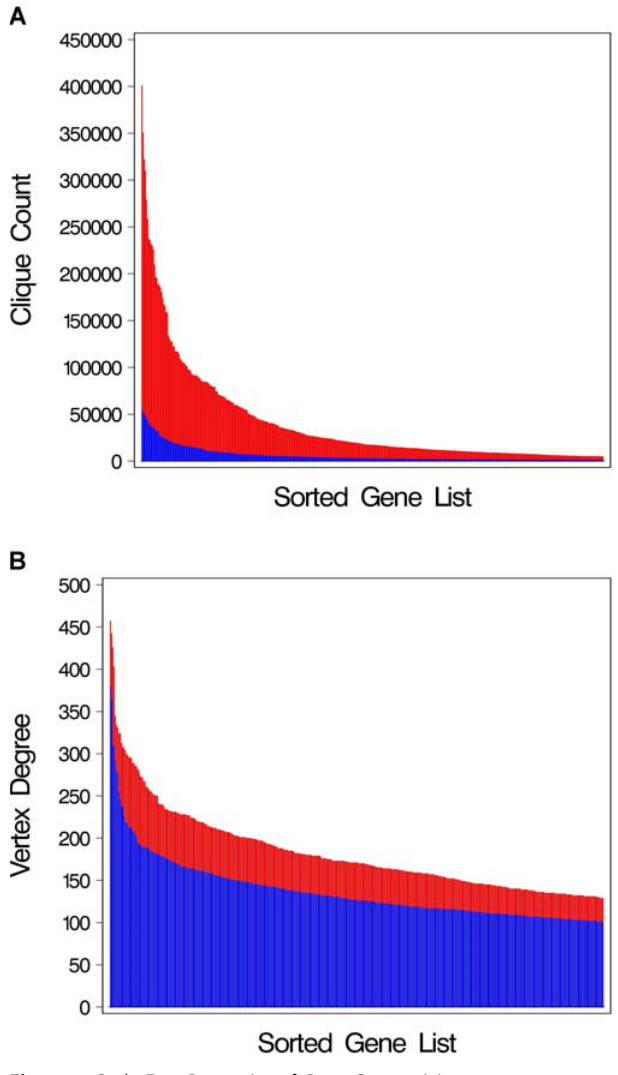
Figure 5. Scale Free Properties of Gene Connectivity Gene lists were sorted in order of abundance for each condition, and the 400 genes most abundant in control (blue bars) and IR (red bars) were plotted against clique membership (A) and vertex degree (B). Although average vertex degree and clique membership were not markedly different between control and IR, the genes most abundant in IR cliques were more highly connected and present in more cliques than in control. DOI: